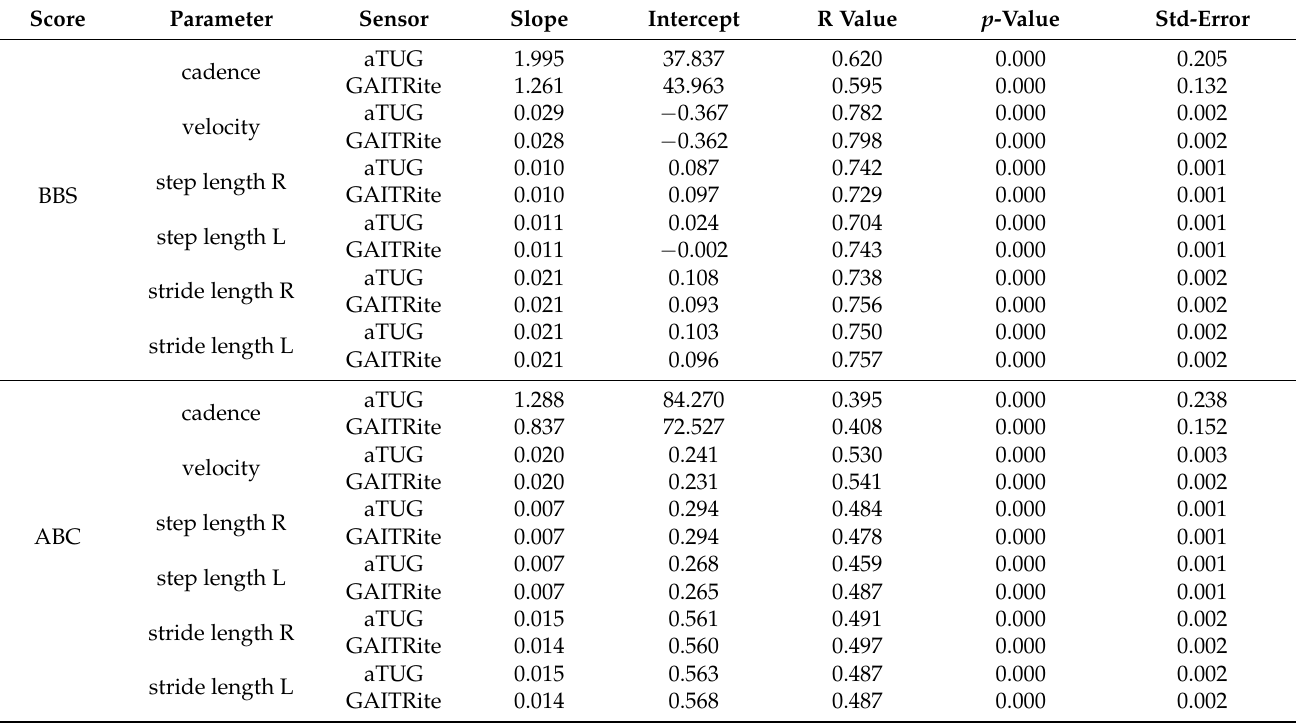
Table 4. aTUG and GAITRite ® Correlation with BBS and ABC